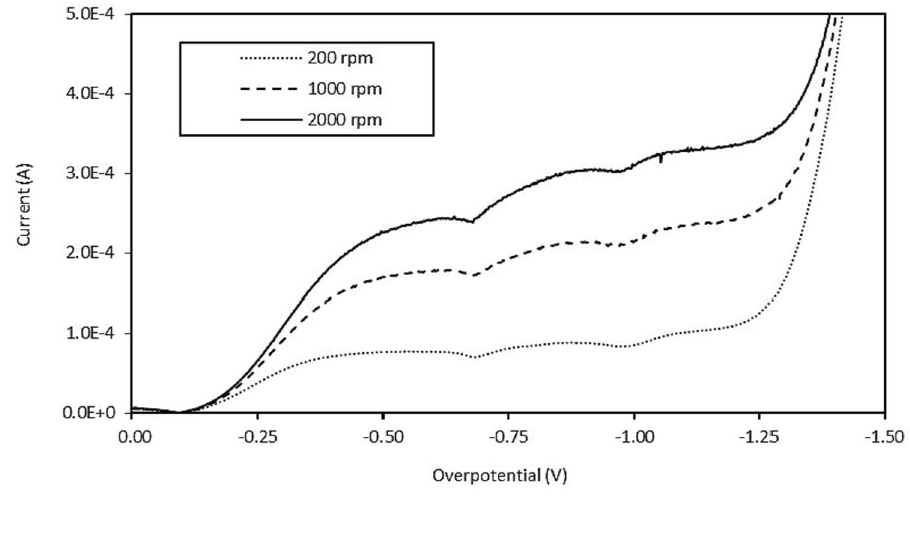
Fig. 7 IV curve for electrode of